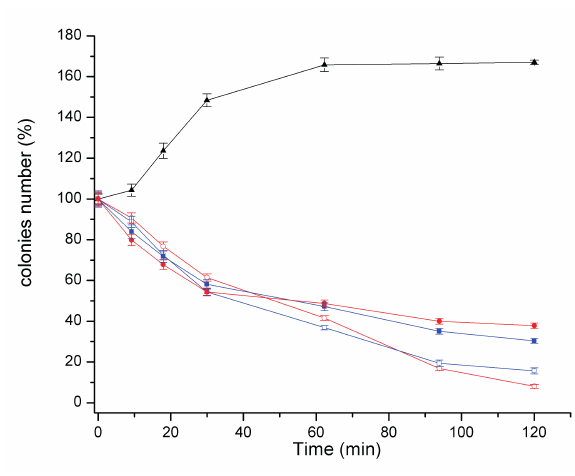
Figure 6: Evolution as a function of time of number of E coli colonies survived in culture media in the presence of PIP (-●-), NAD (-■-), ZnAl- CO (– ▲ –), ZnAl- CO -NAD (–□–), ZnAl- CO 3 3